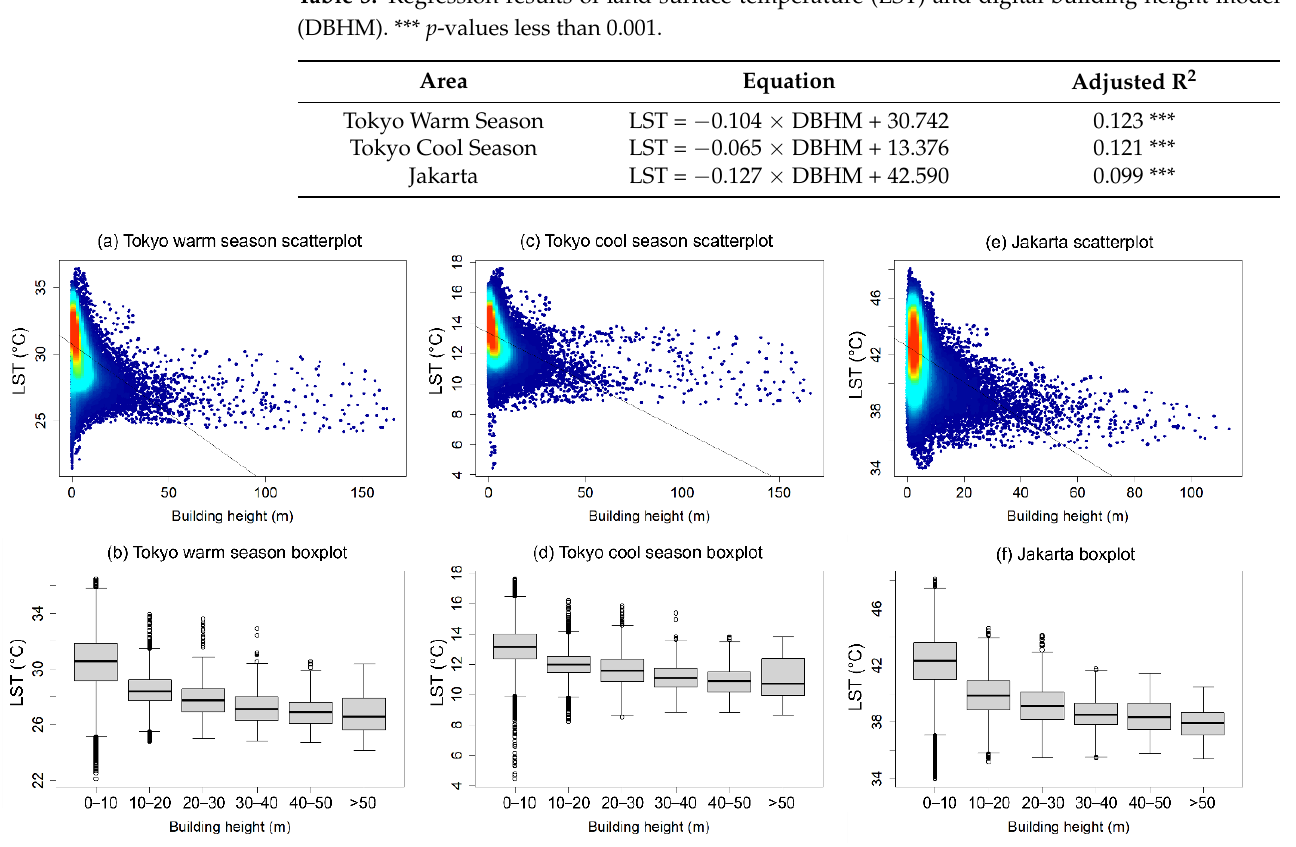
Figure 9. Scatterplots and boxplots of the relationship between averaged LST and